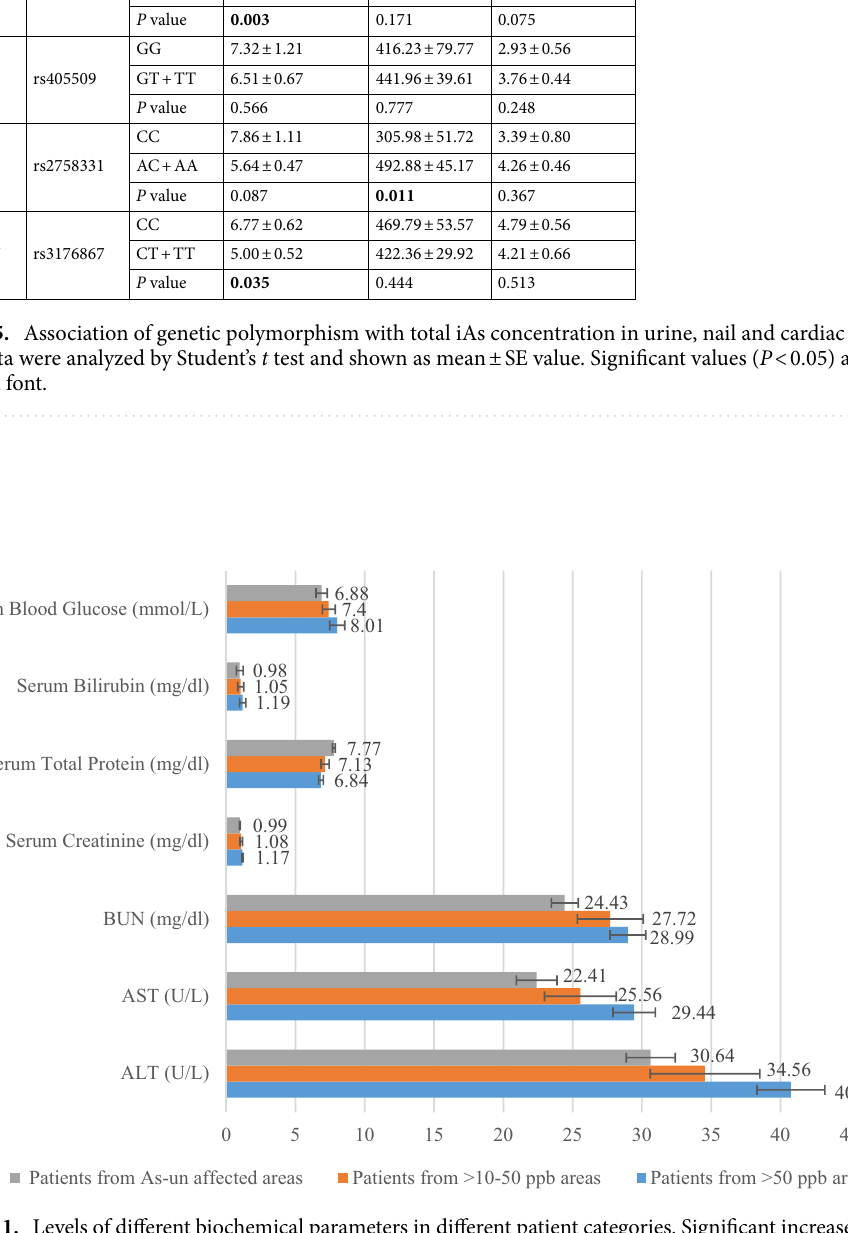
Figure 1. Levels of different biochemical parameters in different patient categories. Significant increase was observed for serum creatinine, BUN, ALT and AST among the patients from iAs-affected areas. Here, ALT = serum alanine amino-transferase, AST = serum aspartate amino-transferase, BUN = blood urea nitrogen. * P < 0.05, Student’s t test for Patient’s group from > 50 ppb iAs-affected areas vs iAs-unaffected